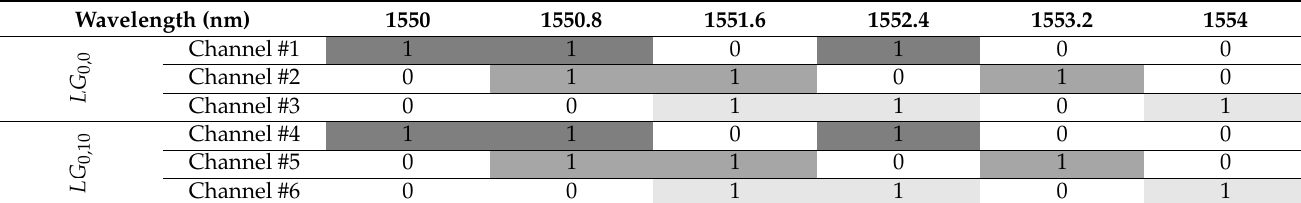
Table 1. Wavelengths assigned to the channels of the FRS